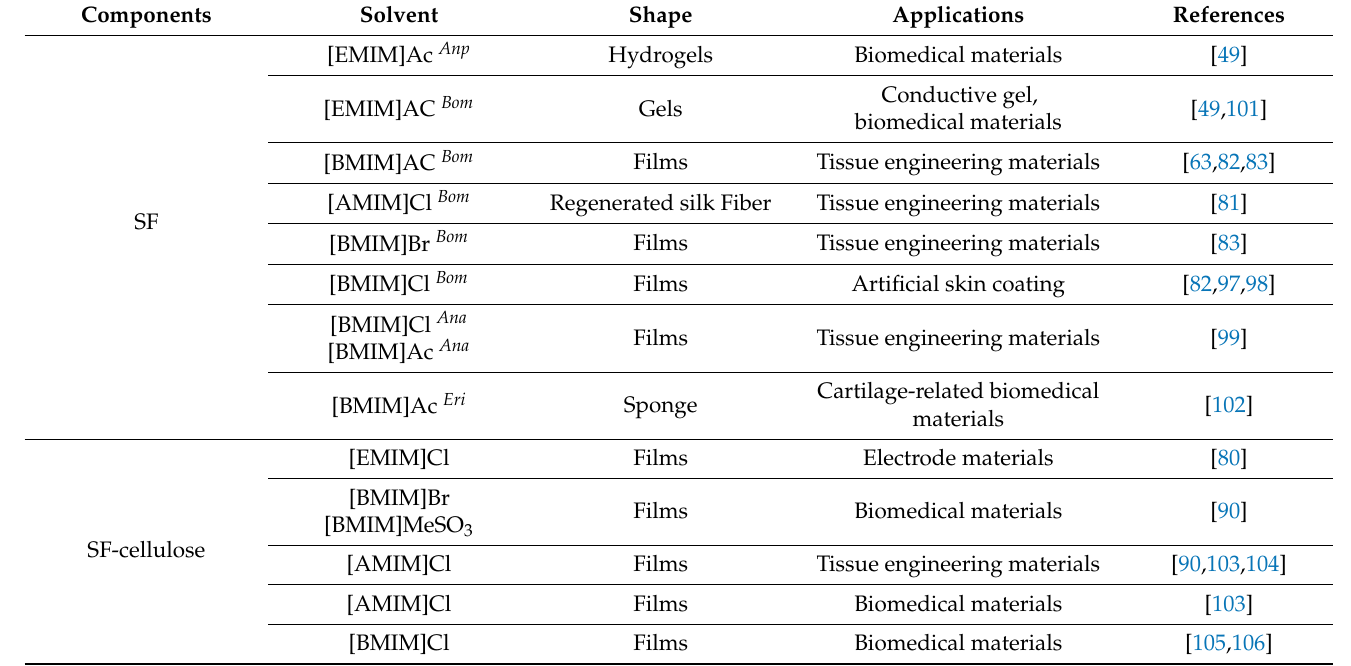
Table 1. Applications of SF-based composites fabricated using various ILs *. Components Shape